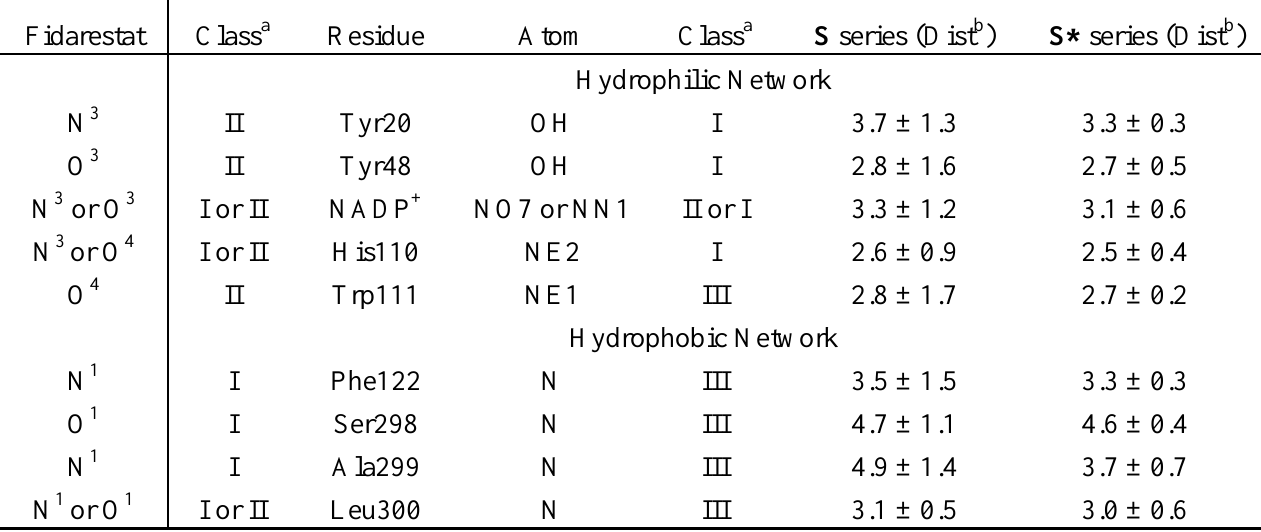
Table 4. Average distances between the atoms of the fidarestat and the ALR2 active